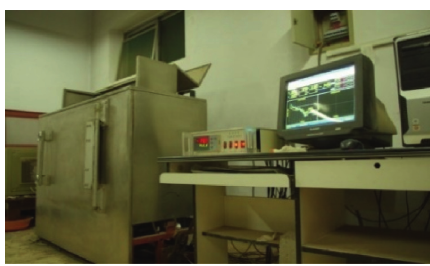
Figure 2: Unconfined compressive strength test.